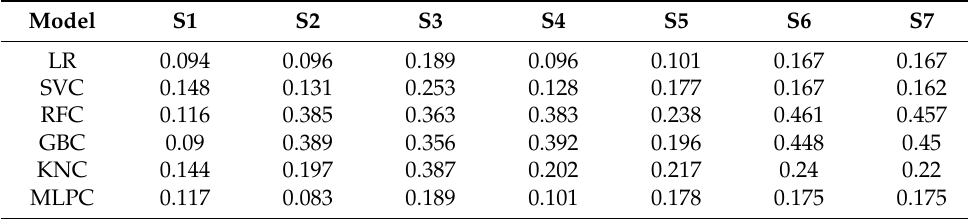
Table 5. PR AUC values for particular algorithms and attribute subsets.